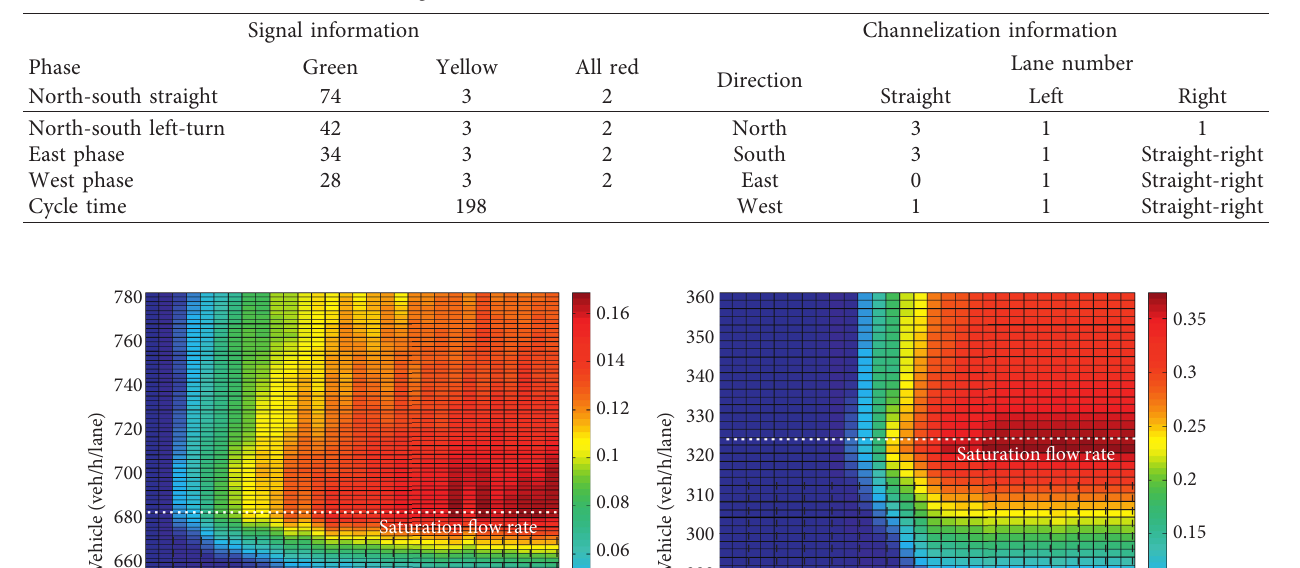
Table 5: Signal and channelization information of case intersection